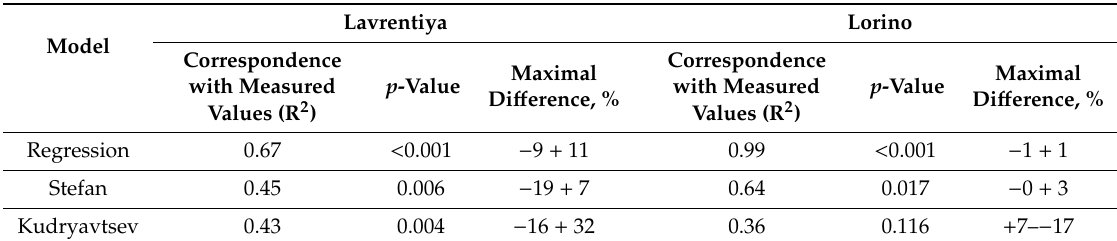
Table 7. Correspondence of modeled and measured active layer thickness (ALT) data on the CALM sites of Eastern